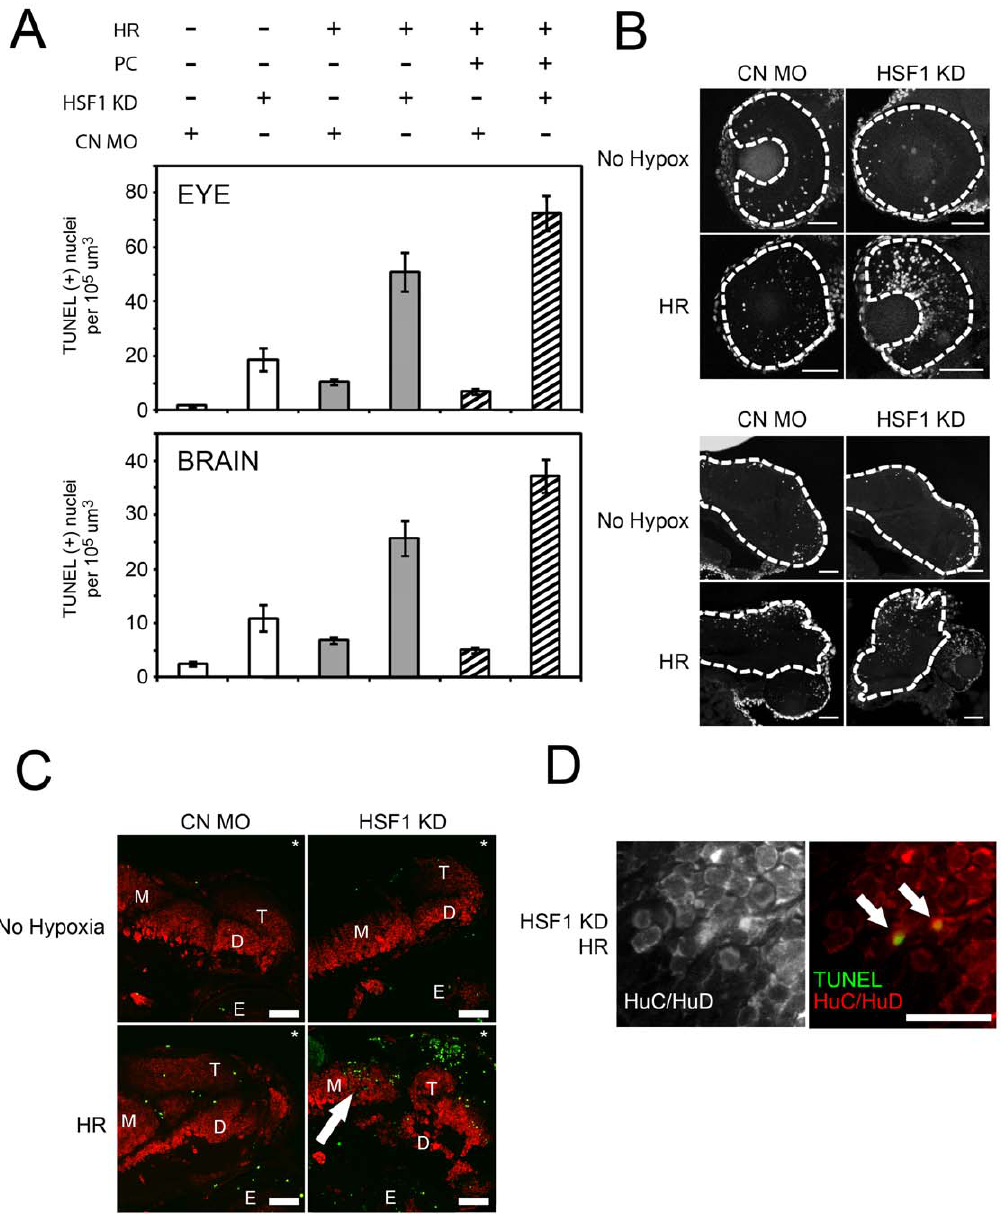
Figure 5. Effects of HSF1 knockdown on apoptosis. A: Quantification of TUNEL positive nuclei in the eye and brain of 58 hpf embryos, showing effects of HSF1 knockdown (compare HSF1 KD versus CN MO), in embryos incubated under control conditions (white bars), after hypoxia/reperfusion only (gray bars), and after heat shock preconditioning followed by hypoxia/reperfusion (striped bars). Error bars are the SEM. B: TUNEL positive cells in representative images of eye (upper panels) and brain (lower panels) regions after hypoxia. Dashed lines indicate the region in which nuclei were counted. Scale bars are 50 m m. C: Analysis of brain morphology and apoptosis after HSF1 knockdown. Representative images showing HuC/HuD immunostaining of neurons (red) and TUNEL positive nuclei (green) in brain sections obtained from embryos injected with control (CN) or HSF1 antisense (HSF1 KD) MO and incubated in normoxic medium (No Hypoxia) or exposed to hypoxia and reperfusion (HR). Asterisks mark the dorsal, anterior aspect of the embryos. Labels are telencephalon (T), midbrain (M), diencephalon (D), and eye (E). Scale bars are 50 m m. D: Representative higher magnification images showing localization of markers for neurons and apoptotic cells in cryosectioned brain. Scale bars are 10 m m.